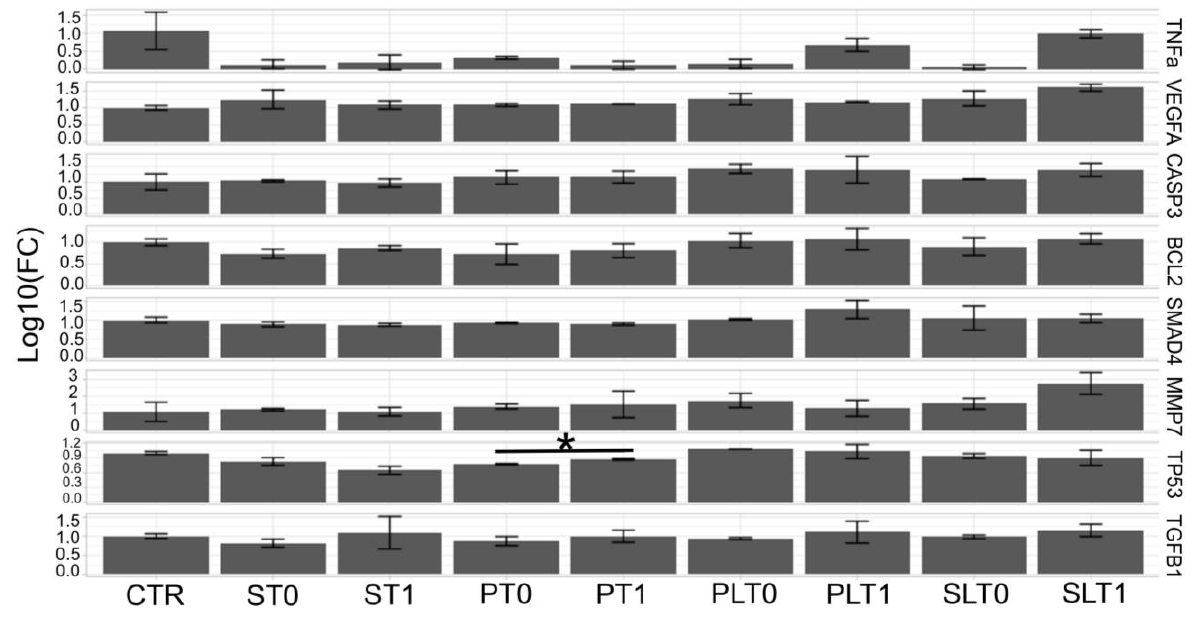
Figure 5. An evaluation of the gene expression levels in the HCT-116 cell line using qRT-PCR. The data are normalized to GAPDH and beta-ACTIN using the ∆∆ CT method (CTR—untreated cells; group PL, before surgery—T0 and after surgery—T1; group P, before surgery—T0 and after surgery—T1; group SL, before surgery—T0 and after surgery—T1; group S, before surgery—T0 and after surgery—T1). The data are represented as mean +/ − standard deviation using the two- sided t -test. The data are represented on a logarithmic scale and the asterisks (*) indicate significant difference at p < 0.05. Table 2. A comparison of gene expressions in study groups, where * is the p -value when comparing T1 with T0.